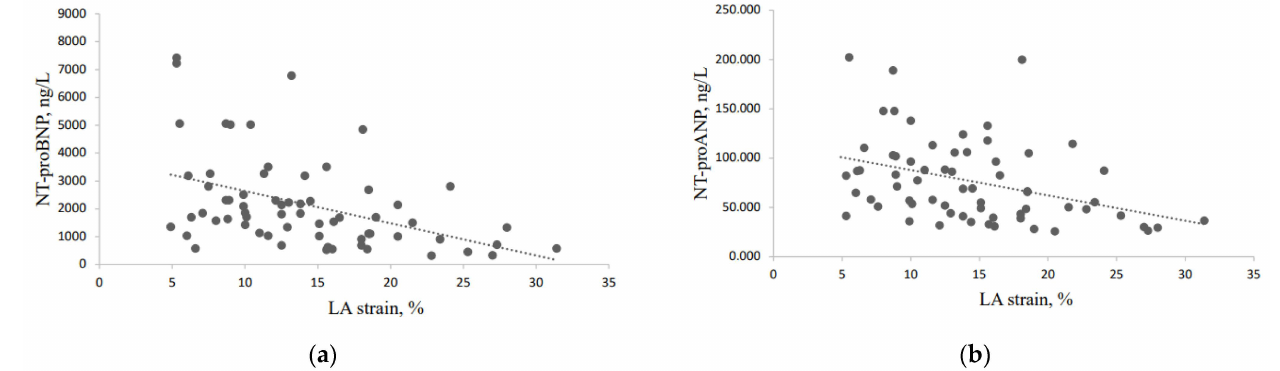
Figure 2. Correlation of left atrial (LA) strain with natriuretic peptides: ( a ) correlation between NT-proBNP and LA strain; ( b ) correlation between NT-proANP and LA strain.